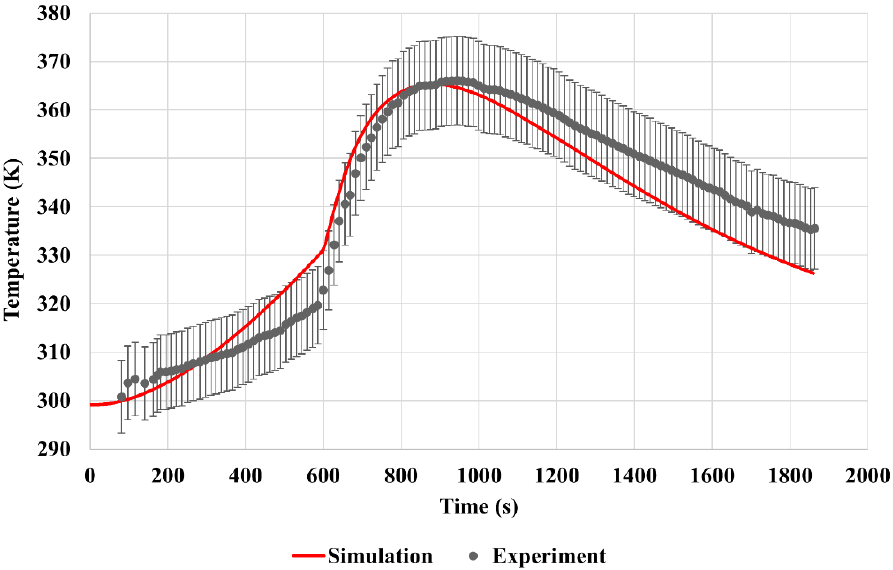
Figure 6. Comparison between the numerical and experimental data for a temperature change of the neighboring cell. The error bar is 2.5%.